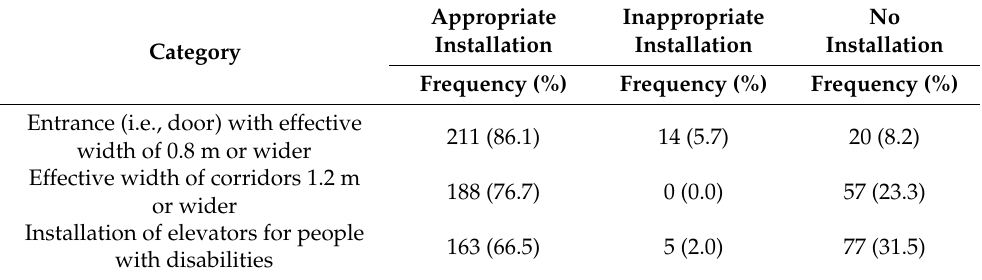
Table 4. Installation state of the internal